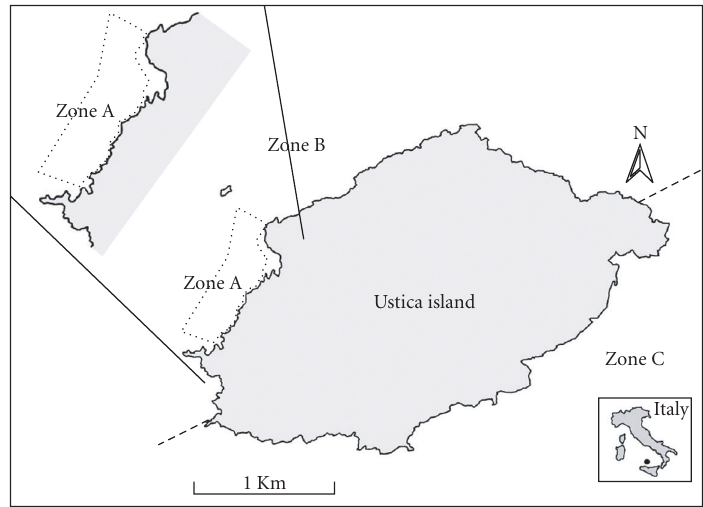
Figure 2: The zones of the Ustica marine protected area and the no-take area of the reserve.